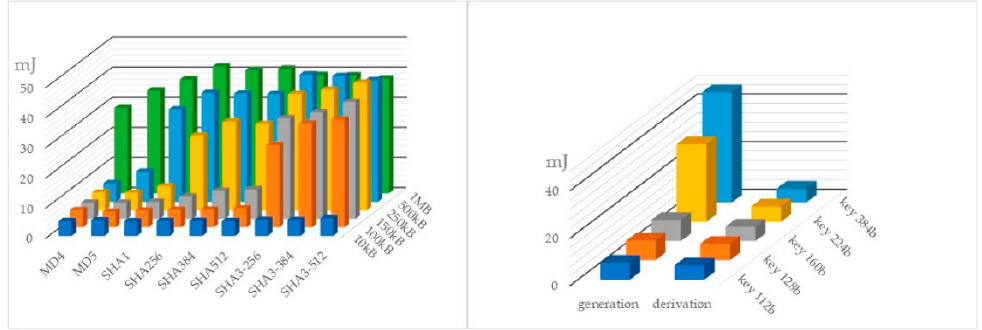
Figure 6. The energy consumption of the main crypto mechanisms in relation to their type, key length and file size (hash functions on the left, and ECC-Secpr1 on the right).